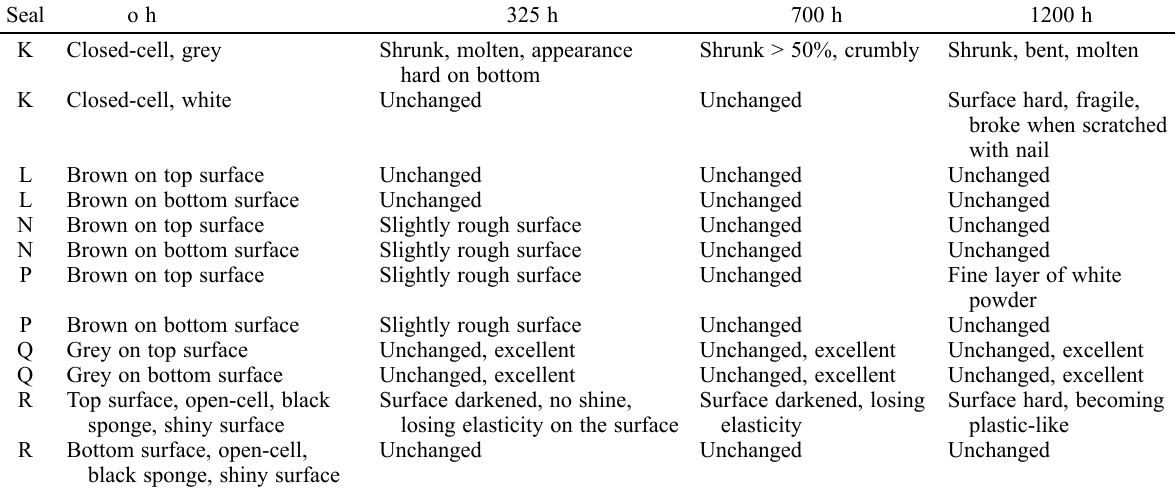
Table 3. Effect of UV light with intermittent water spray on the surface of FMS Sealant o h White, smooth surface Grey Light yellow, smooth surface Grey, a few black spots Grey Grey with holes, smooth surface Grey, micro-bubbles Grey Dark brown, smooth shiny surface